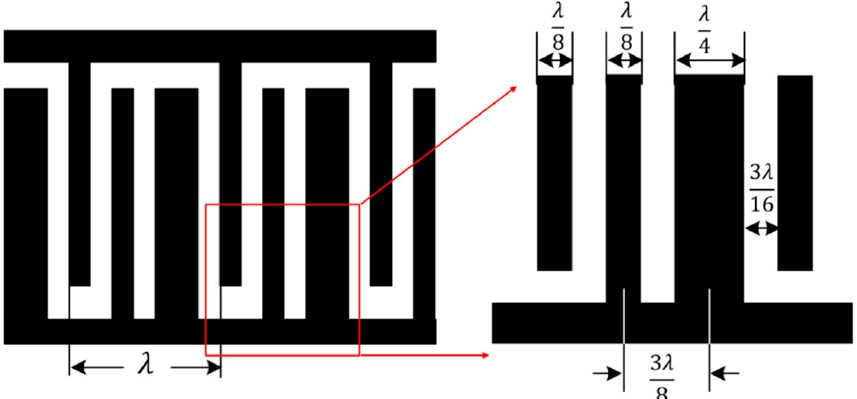
Figure 1. A magnified image of the EWC/SPUDT structure.